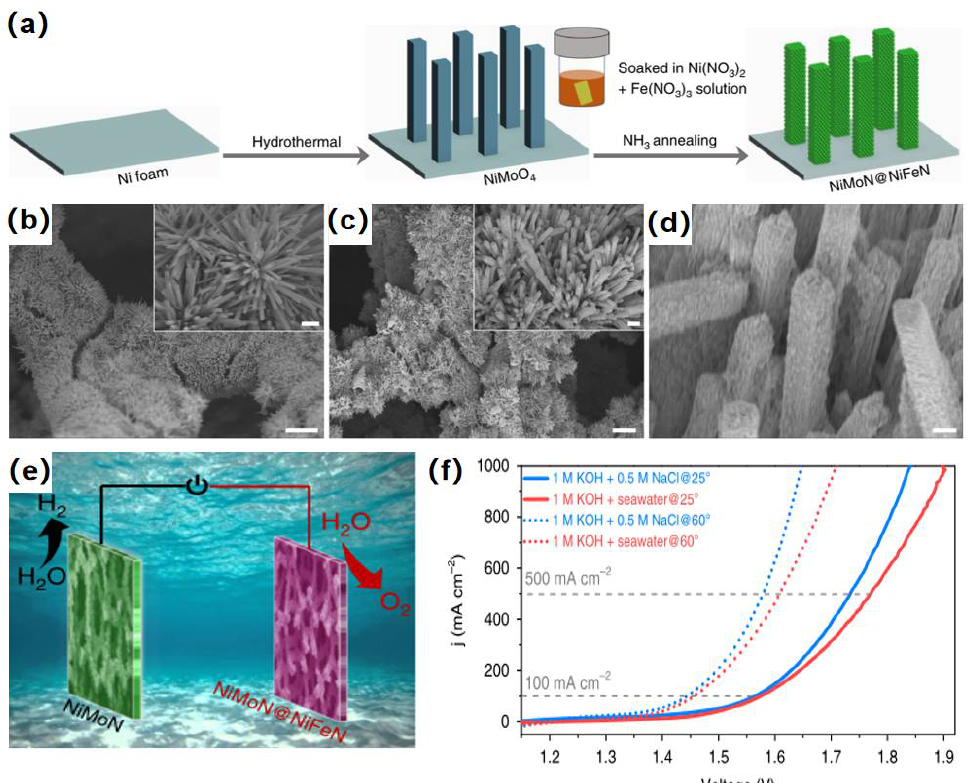
Figure 4. ( a ) Schematic diagram of the synthesis of NiMoN@NiFeN, ( b ) SEM images of NiMoN, ( c , d ) SEM images of NiMoN@NiFeN, ( e ) schematic diagram of an electrolyzer using NiMoN and NiMoN@NiFeN as catalysts, and ( f ) LSV curves of NiMoN and NiMoN@NiFeN. Reproduced with permission from [18]. Copyright © 2019, Springer Nature.